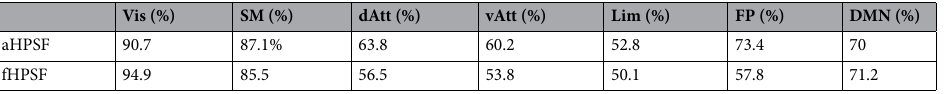
Table 1. The overlapping percentages of merged iFC maps with different resting-state functional networks. Vis visual network; SM sensorimotor network; dAtt dorsal attention network; vAtt ventral attention network;